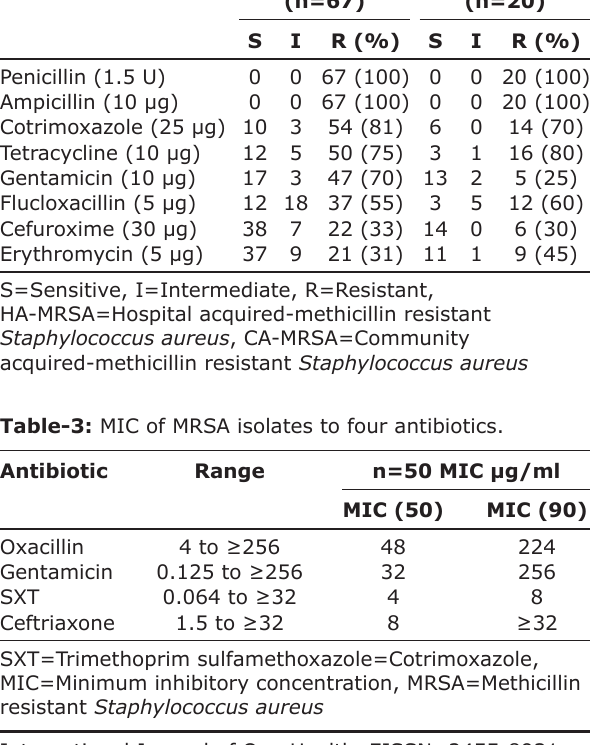
Table-2: Susceptibility patterns of HA-MRSA and CA-MRSA isolates. Antibiotic